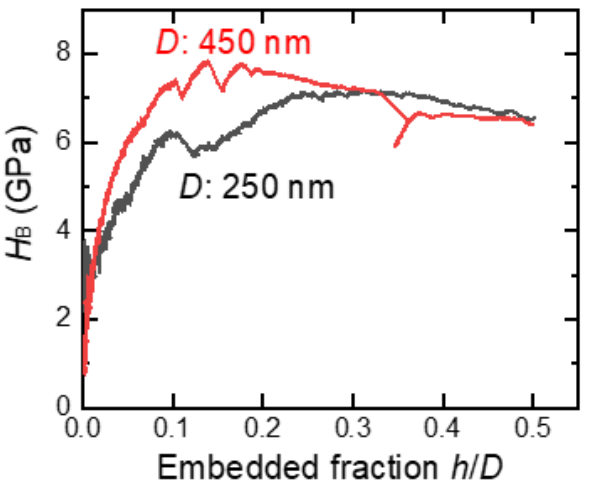
Figure 11. Brinell hardness variations calculated using Equation (3) from the initial stage of particle embedment data in Figure 10.